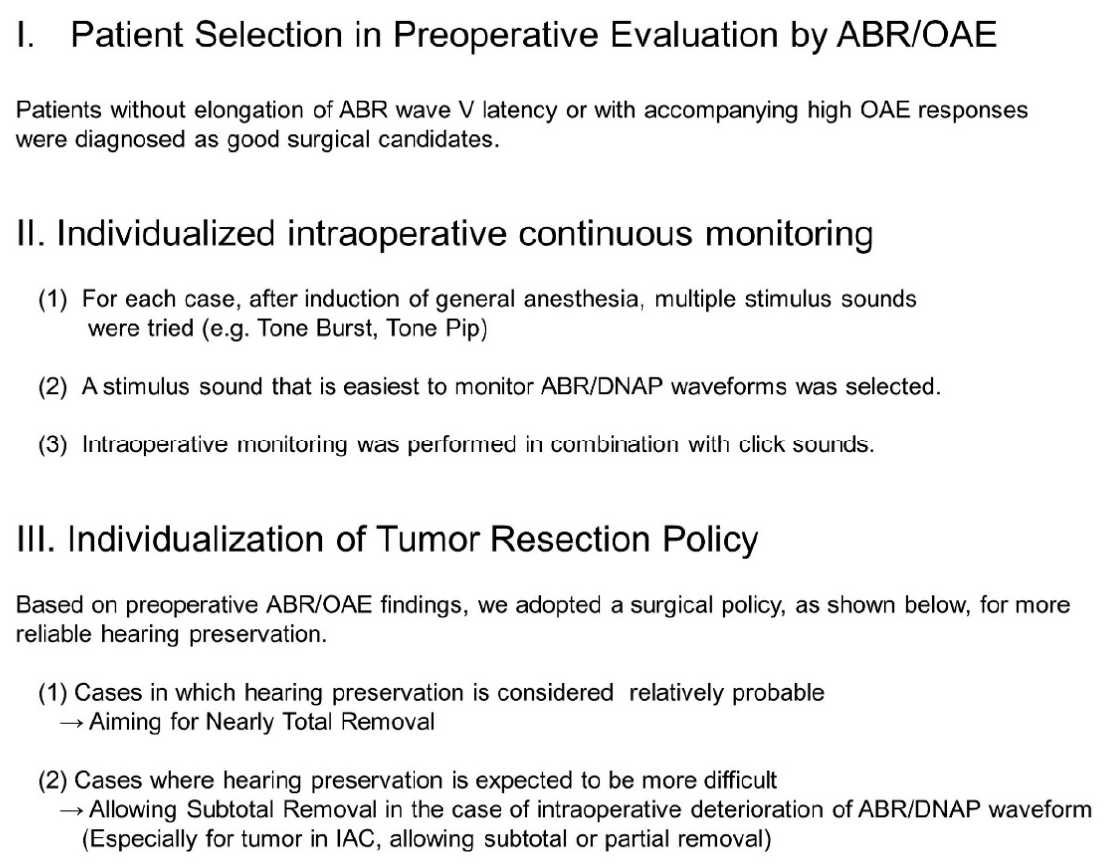
Figure 1. Surgical concepts of endoscope-assisted retrolabyrinthine approach under modified rein- forced continuous intraoperative monitoring for hearing preservation in our hospital. We have added modifications and improvements to our previous methods of patient selection, monitoring methods, and tumor resection policies. ABR, auditory brainstem; DNAP, dorsal cochlear nucleus activation potential; OAE, otoacoustic emission; IAC, internal auditory canal.